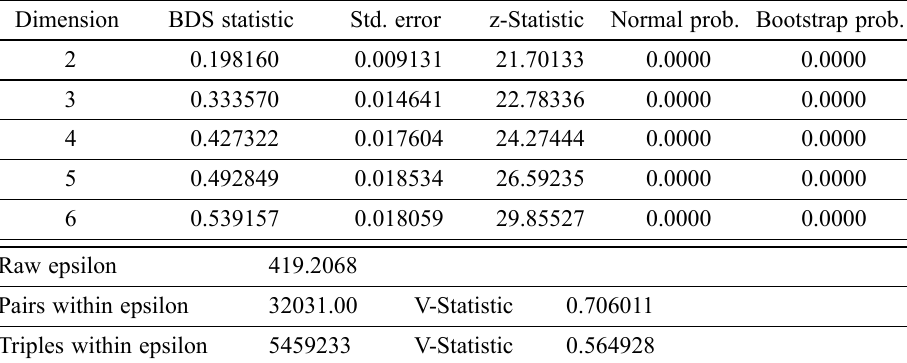
Table 3. BDS test results for LR, CPI,